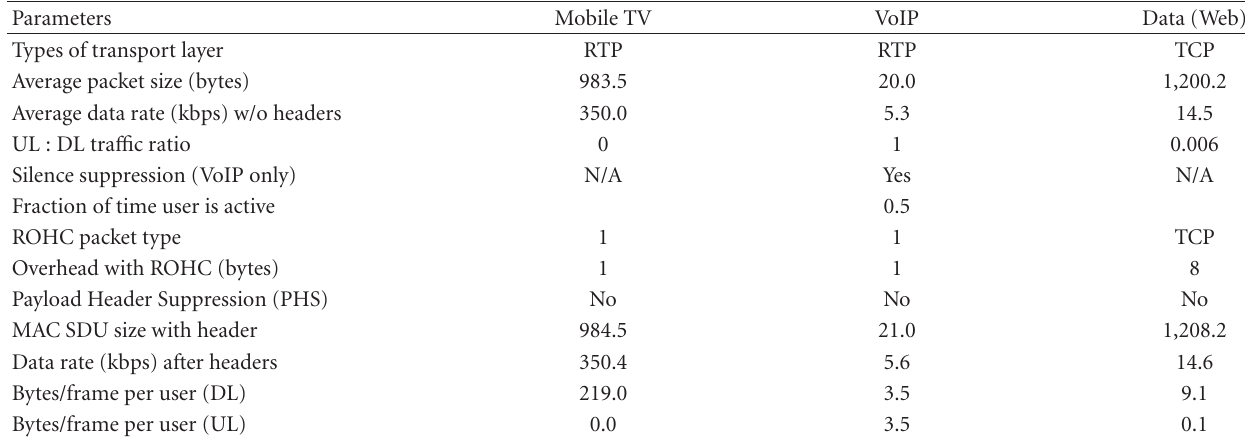
Table 8: Summary of workload characteristics.